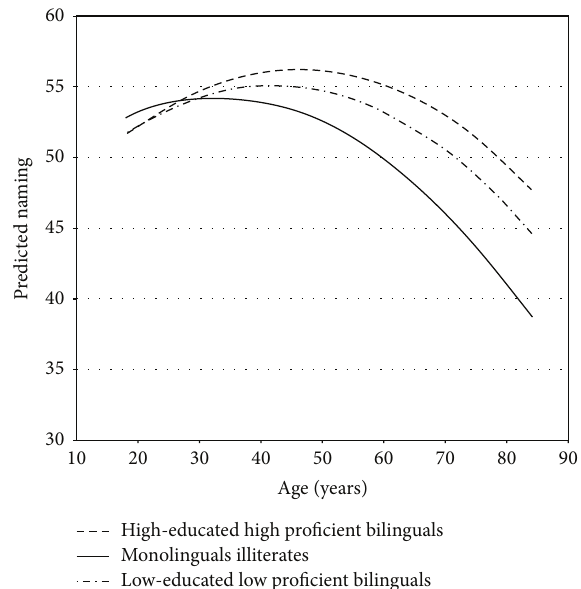
Figure 1: Estimated nonlinear effect of age (age 2 ) for high education high proficient bilinguals (education = 10, L2 proficiency variables = 3), low-educated low proficient bilinguals (education = 4, L2 proficiency variables = 2), and monolingual illiterates.